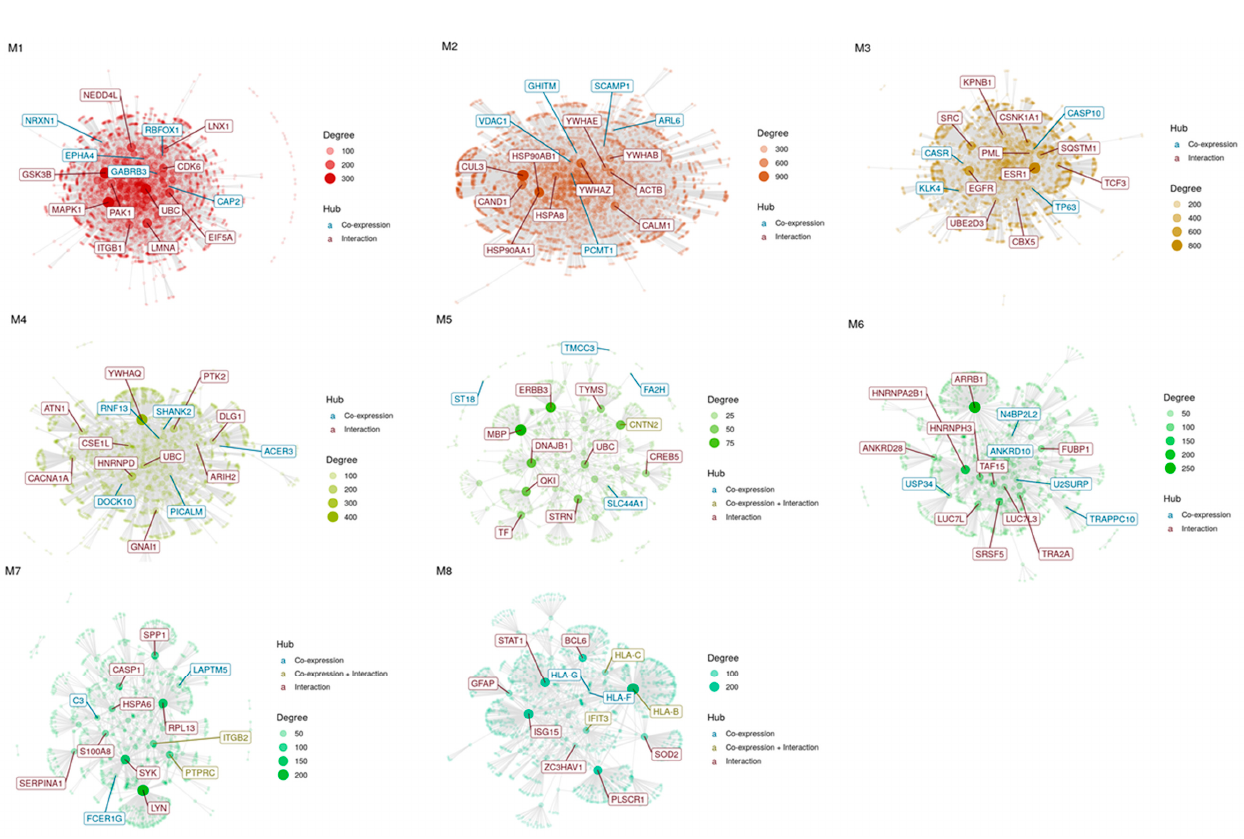
Figure 2. Gene co-expression network modular analysis. PPI network for each of the modules identified in the co-Expression network modular analysis of the GSE35864 dataset. Hub genes are indicated in red.